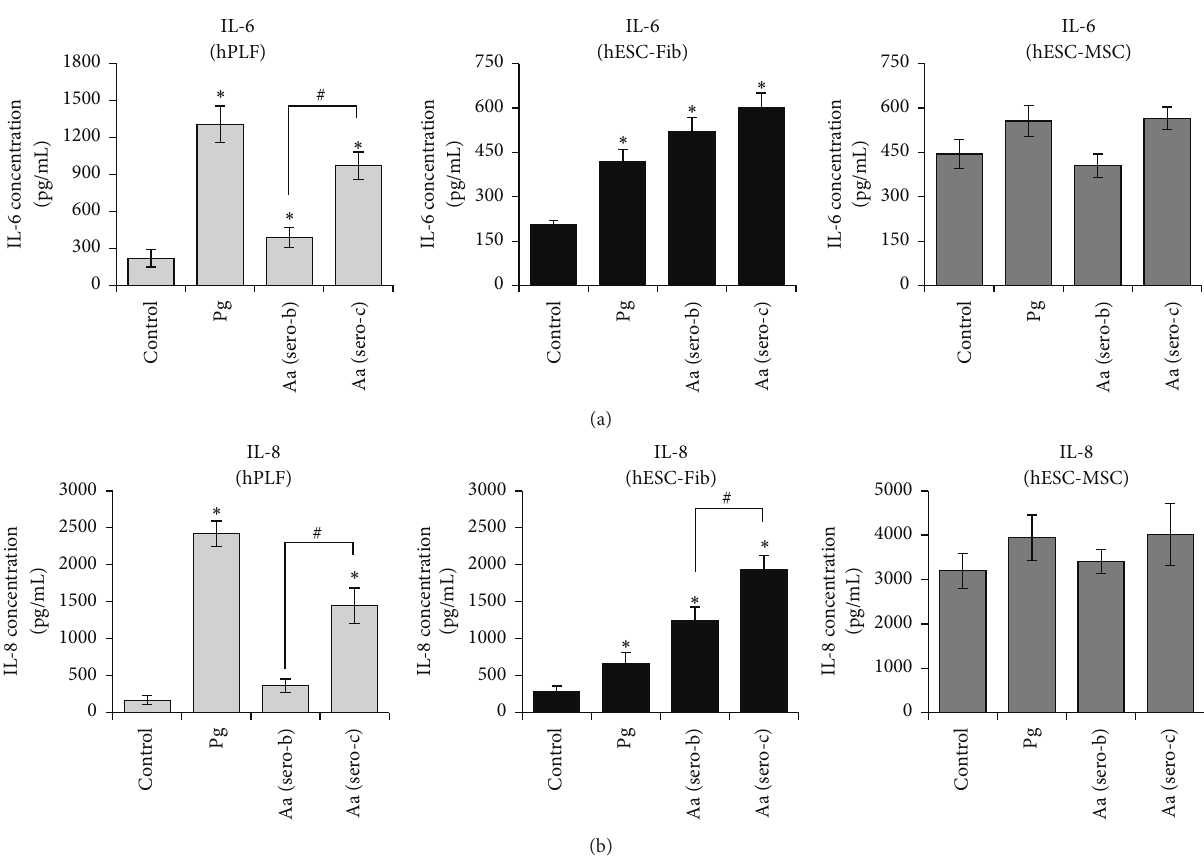
Figure 7: IL-6 (a) and IL-8 (b) production in the culture supernatants (assayed using ELISA) from hPLFs, hESC-Fib, and hESC-MSCs in response to exposure to P. gingivalis (Pg) and two different serotypes of A. actinomycetemcomitans (Aa serotypes b and c). Values represent the means ± SD of three experiments ( ∗ 𝑝 < 0.05 versus untreated control; # 𝑝 < 0.05 versus different serotypes of A. actinomycetemcomitans